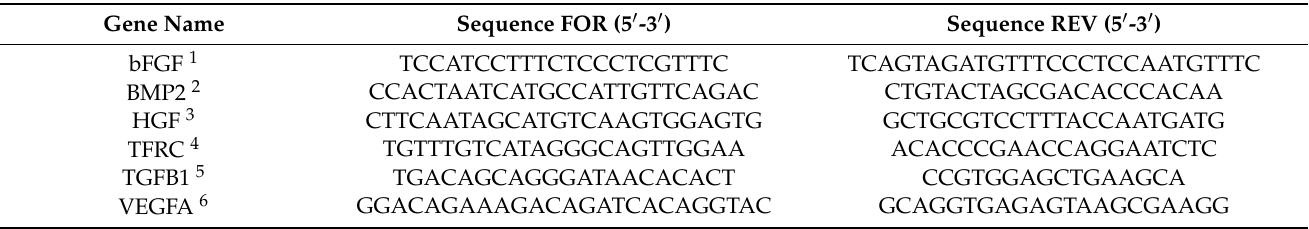
Table 1. Human-gene-specific primers used in this